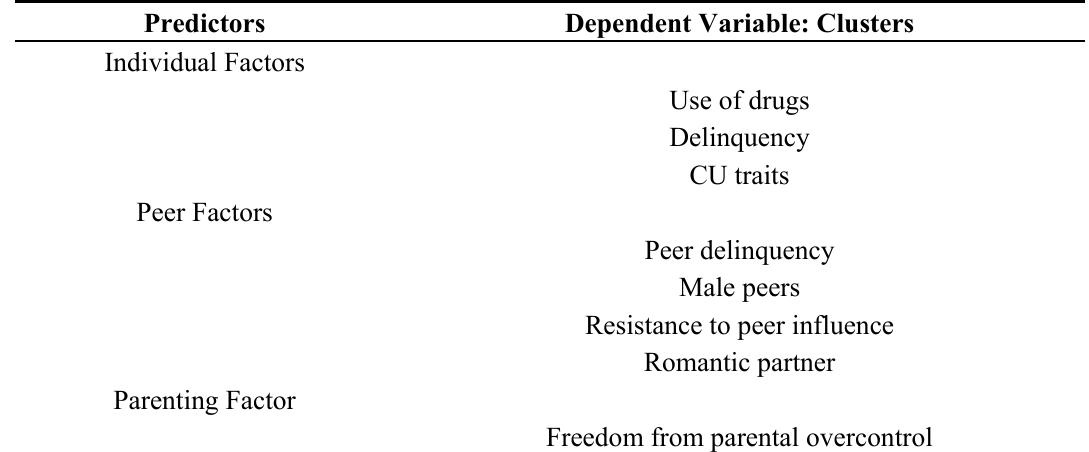
Table 1. Data analysis plan in predicting reactive and proactive relational aggression clusters. CU,